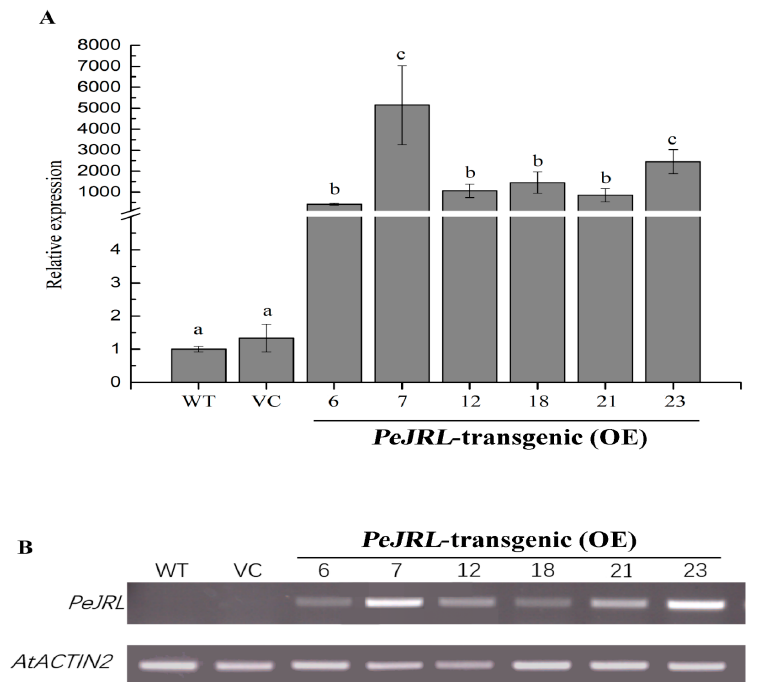
Figure 4. Overexpression of PeJRL in Arabidopsis. ( A ) RT-qPCR assays of PeJRL overexpression (OE) after transformation. Arabidopsis thaliana actin 2 ( AtACTIN2 ) served as the internal control. Forward and reverse primers are shown in Supplementary Materials Table S1. Each column corresponds to the mean of three individual plants, and bars represent the standard error of the mean. Columns labelled with different letters (a–c) indicate significant differences ( p < 0.05) between wild-type (WT), vector control (VC), and transgenic lines. ( B ) Semi-quantitative reverse-transcription PCR (RT-PCR) analysis of PeJRL in WT, VC, and transgenic lines (#6, #7, #12, #18, #21, and #23).